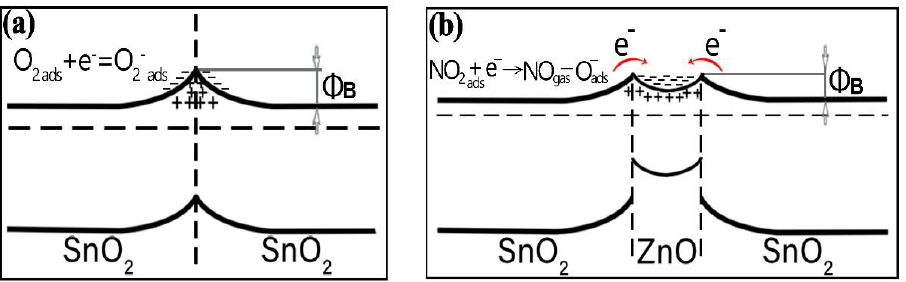
Figure 11. Flat band scheme of crystallite contacts for SnO 2 -SnO 2 ( a ) and SnO 2 -ZnO-SnO 2 ( b ). As can be seen from , gas sensors based on the film material 0.5ZnO-99.5SnO 2 show a peak response to NO 2 exposure, compared to other samples.